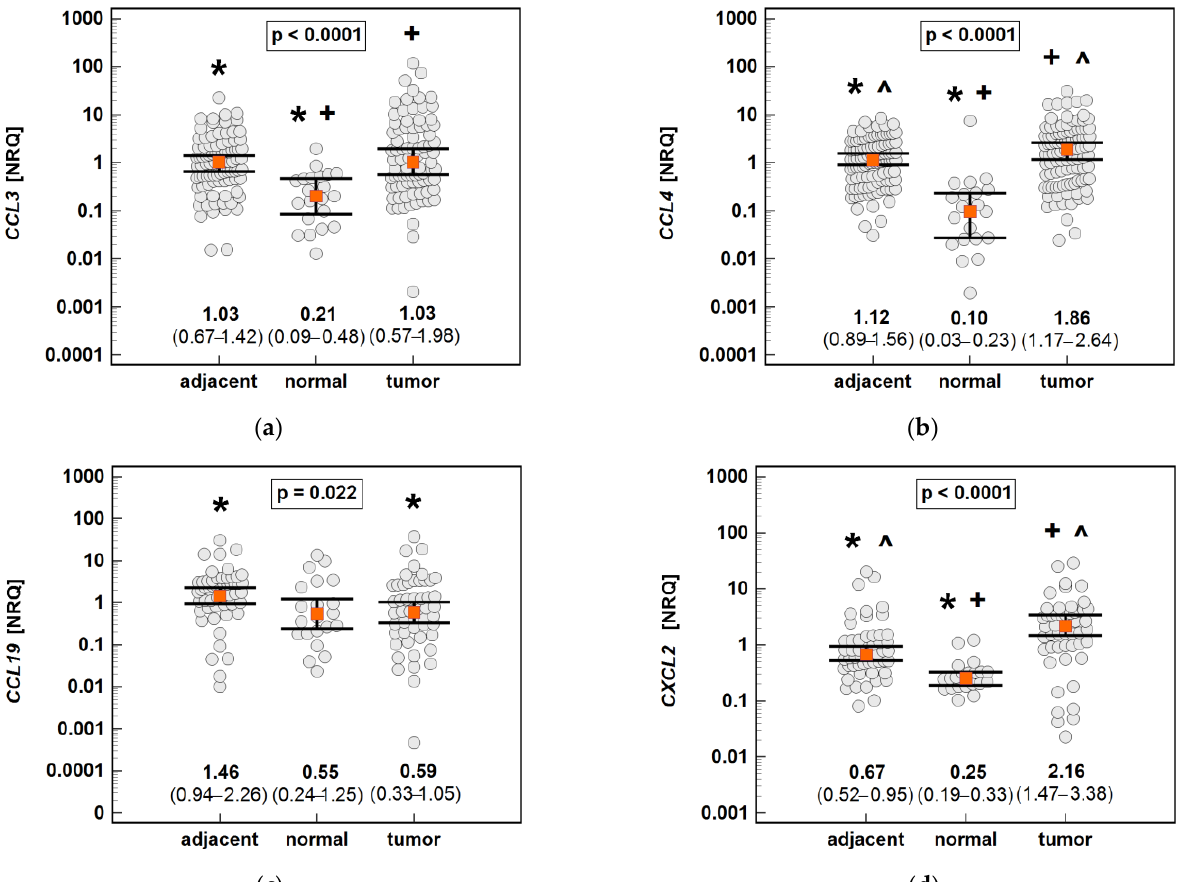
Figure 15. An expression of the MIP chemokines in tumor and tumor-adjacent tissue compared to normal mucosa from non-cancer patients: ( a ) CCL3 ; ( b ) CCL4 ; ( c ) CCL19; ( d ) CXCL2 . The data are presented as means ( CCL19 ) or medians ( CCL3 , CCL4 , and CXCL2 ) with 95% confidence intervals. The data were analyzed using one-way ANOVA with a Student-Newman-Keuls post hoc test or a Kruskal – Wallis H test with a Conover post hoc test, respectively. The significant between-group differences are indicated by the same type of symbol: *, +, or ^. NRQ, normalized relative quantities.